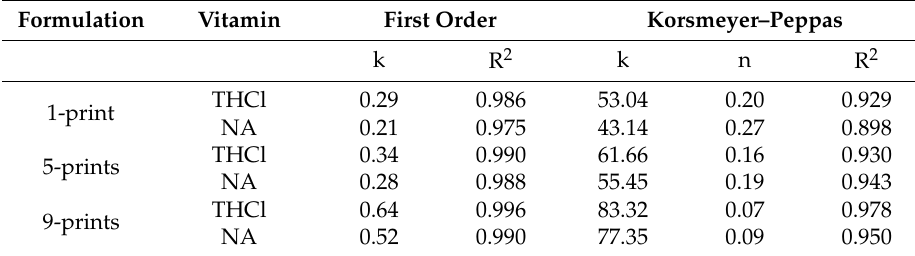
Table 3. Kinetic models fitting